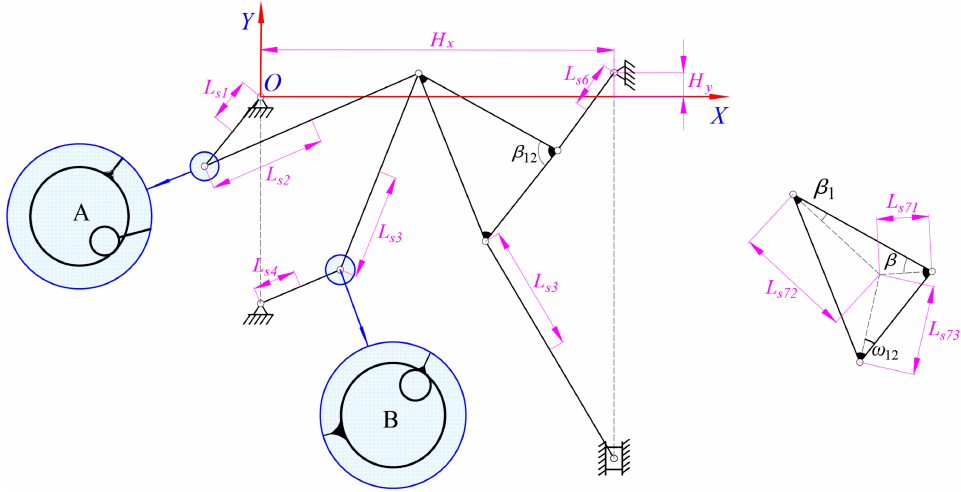
Figure 4. Structure diagram of a 2- DOF nine-bar mechanism with revolute clearances.